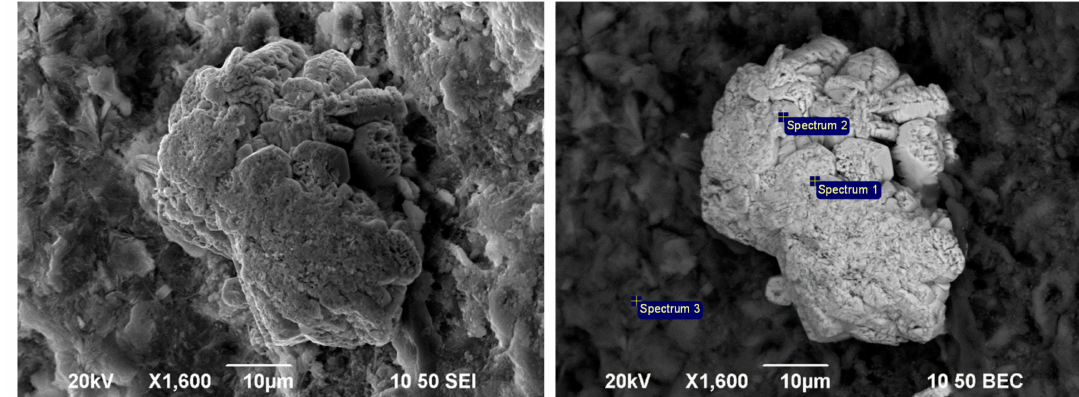
Figure 10. SEM secondary electron image ( left ) and corresponding backscattered electron image with three marked points for saturated NZHg ( right ).